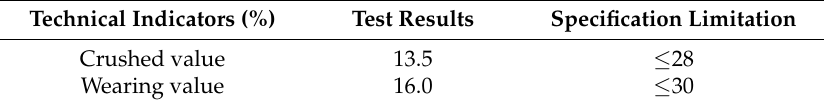
Table 5. Crushed value and wearing values of coarse aggregate.